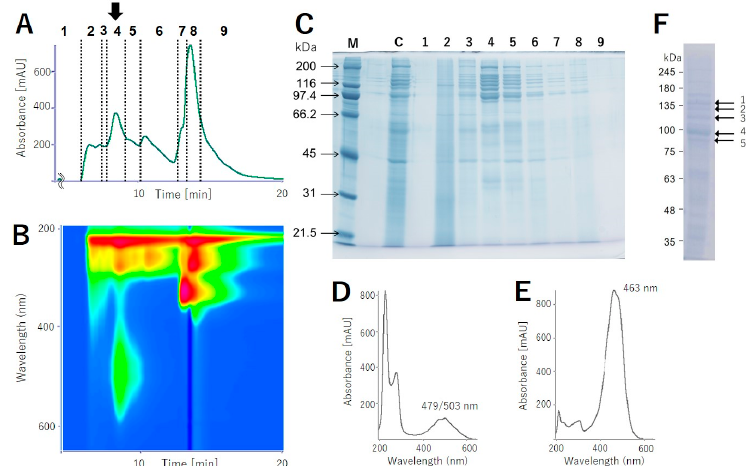
Figure 1. ( A ) The chromatogram at 280 nm and ( B ) HPLC absorbance spectrum from pectenovarin purification using a photodiode array detector (PDA). ( C ) SDS-PAGE of the HPLC fractions. M: size marker; C: the crude extract of the scallop ovary; 1–9: the fraction numbers corresponding to Figure 1A. ( D ) Absorbance spectrum of pectenovarin at T R = 8.459 min and ( E ) pectenolone in acetonitrile/methanol/water at 50:50:1. The peak maxima of the carotenoid chromophore of pectenovarin are at 479 and 503 nm, while that of pectenolone is at 463 nm. ( F ) The ladder-like bands originally appeared and gradually converged at 95 kDa (band 4) after several freeze-thaw processes.